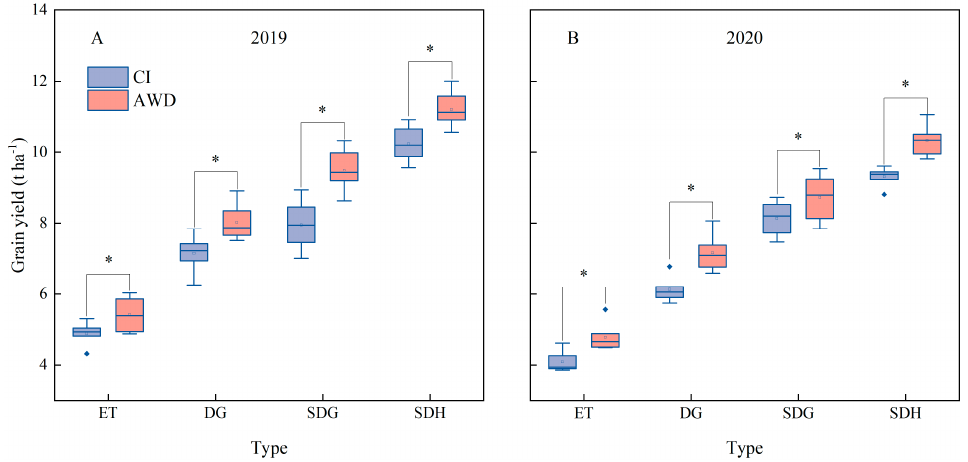
Figure 1. Effect of irrigation on grain yield of mid-season indica rice genotypes during the ( A ) 2019 and ( B ) 2020 growing seasons. ET denotes early tall genotype, DG denotes dwarf genotype, SDG denotes semi-dwarf genotype, and SDH denotes semi-dwarf hybrid. CI and AWD represent conventional irrigation treatment and alternate wetting and drying irrigation treatment, respectively. * indicates significant differences at p ≤ 0.05. Table 3. Effect of irrigation on grain yield components of mid-season indica rice genotypes during the 2019 and 2020 growing